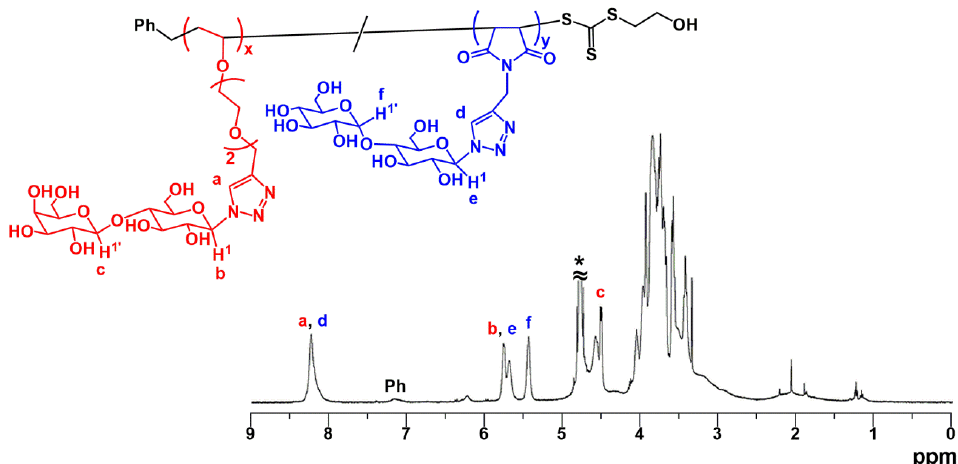
Figure 7. 1 H NMR spectrum of poly(LacVE- co -MalMI) in D 2 O.